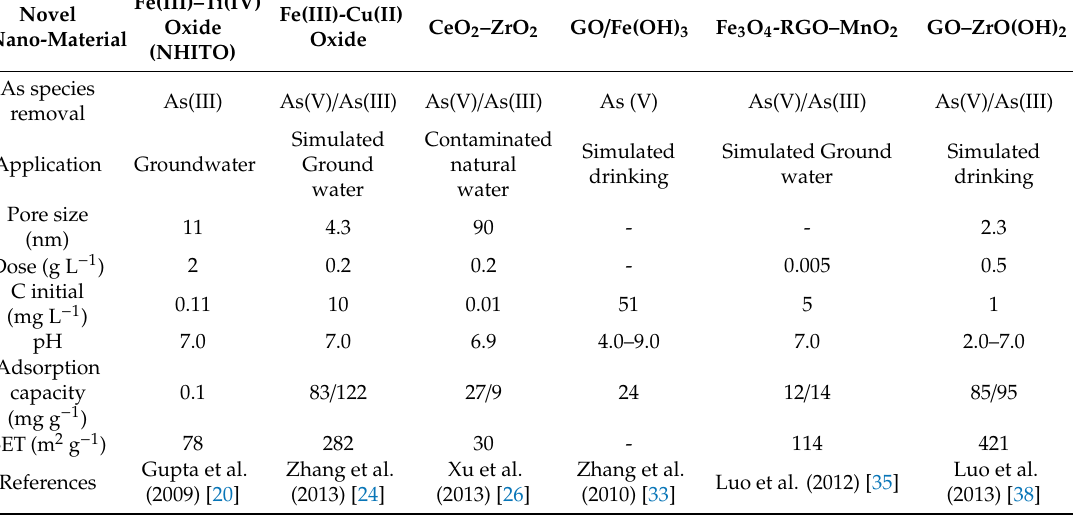
Table 1. Novel nanostructured materials utilized for the removal of arsenic from waters.